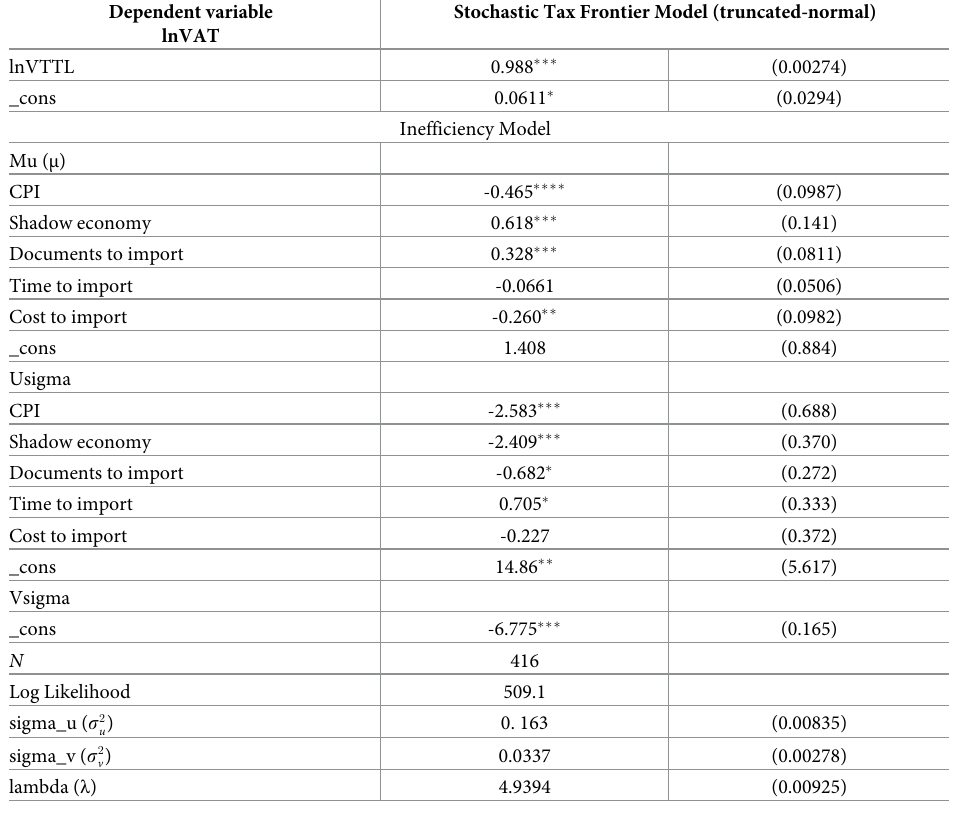
Table 2. Stochastic tax frontier model estimation, panel data for 26 EU countries,